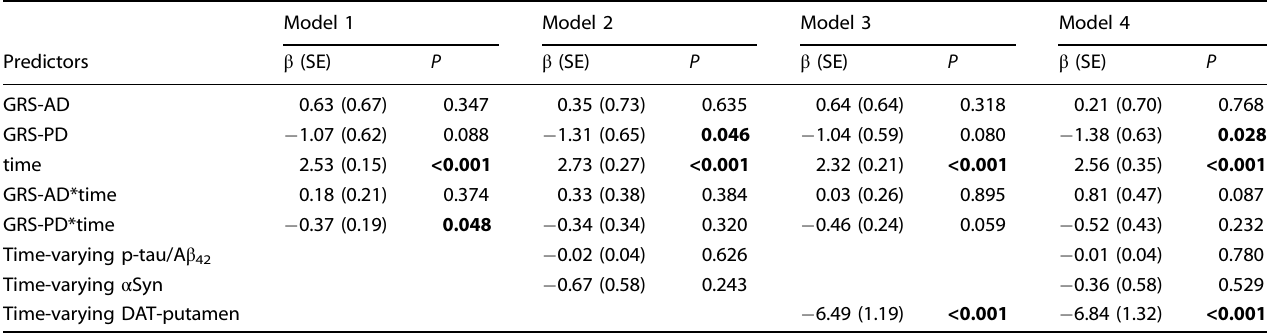
Table 5. Effects of genetic risk scores and CSF biomarkers on longitudinal motor severity scores in PD